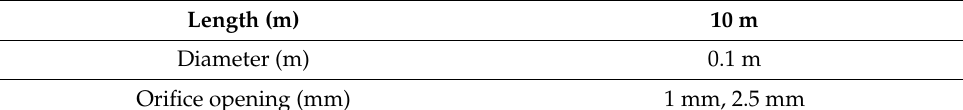
Figure 1. The new concept of wave energy extraction by forcing water flow through a submerged pipe. An orifice plate is used to represent the effects of turbine damping.